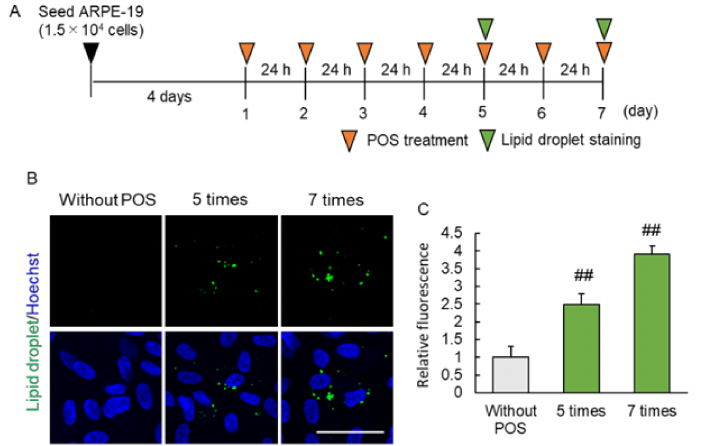
Figure 2. Lipid droplet accumulation via POS phagocytosis. ( A ) Experimental protocol of POS treatment induced lipid droplet accumulation. Green arrow head shows lipid droplet staining timepoint, and orange arrow head shows POS treatment timepoint. ( B ) The representative image of lipid droplet (green) and Hoechst 33,342 (blue) following continuous (5- and 7-times) POS treatment. Scale bar shows 50 µ m. ( C ) The quantitative data of the fluorescence intensity of lipid droplet. Data are the means ± SEMs ( n = 4 independent experiments). ## p < 0.01 vs. without POS group (Dunnett’s